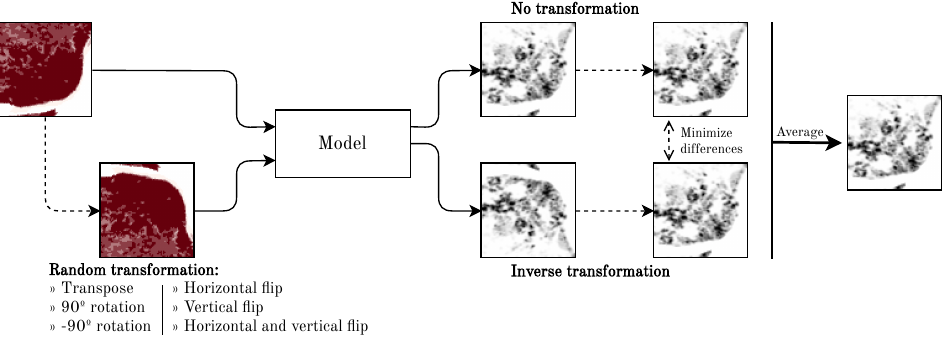
Figure 4. Illustration of the strategy used to encode equivariances to geometric